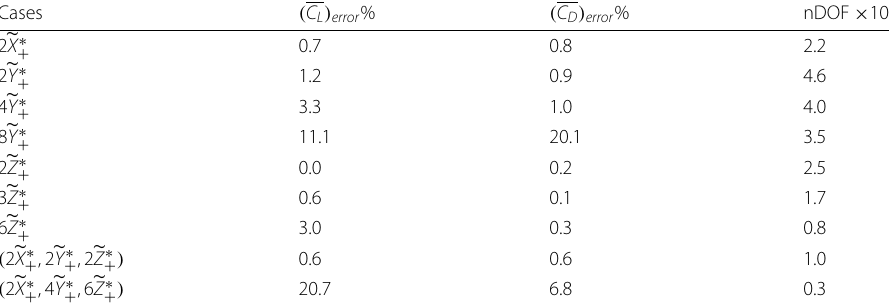
Table 2 Relative error of the mean C L and C D with respect to the DNS solution for the coarse LES